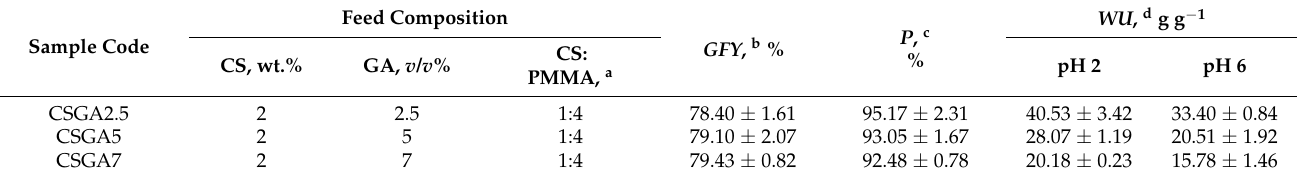
Table 1. The sample codes, the feed composition, and some characteristics of the CS-based cryogels.